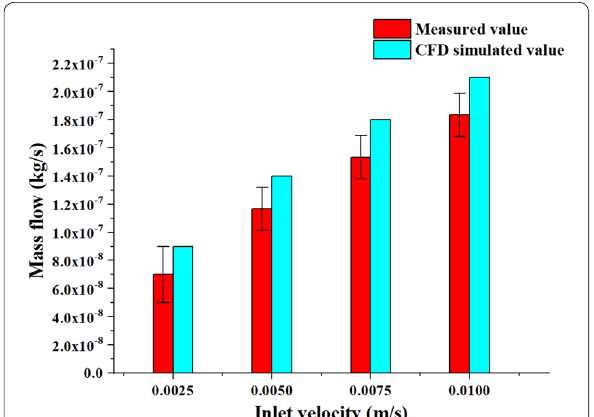
Figure 16 Mass flow in the bottom outlets obtained using CFD simulation and actual measurement (the pore diameter is 434 μm)